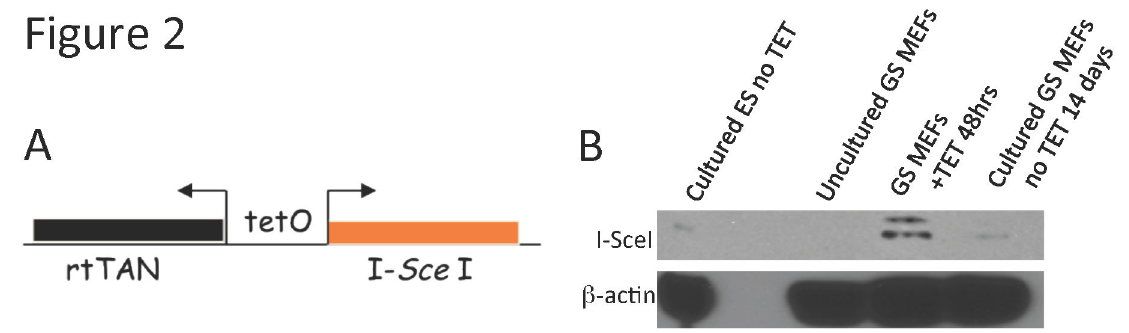
Figure 2. Structure and confirmation of the tetracycline inducible I- Sce I transgene. ( A ) For details of the bicistronic I- Sce I transgene construct refer to [65]. ( B ) MEFs derived from GS mice were cultured in media supplemented with TET at 2μg/mL for 48 hours. Total protein extracts were harvested and analyzed by Western blotting. By 48 hours post-TET, detectable quantities of I- Sce I endonuclease can be observed. As a negative controls, total protein extracts were harvested from cultured E14 ES cells or uncultured MEFs from GS mice. Loading control: Western blotting for β-actin. doi: untreated cells with a gate set at 0.1%; n=12) (Figure 3B). Individual GFP+ cells were FACS sorted and confirmed to be GFP+ by inverted fluorescent microscopy (Figure 3C).